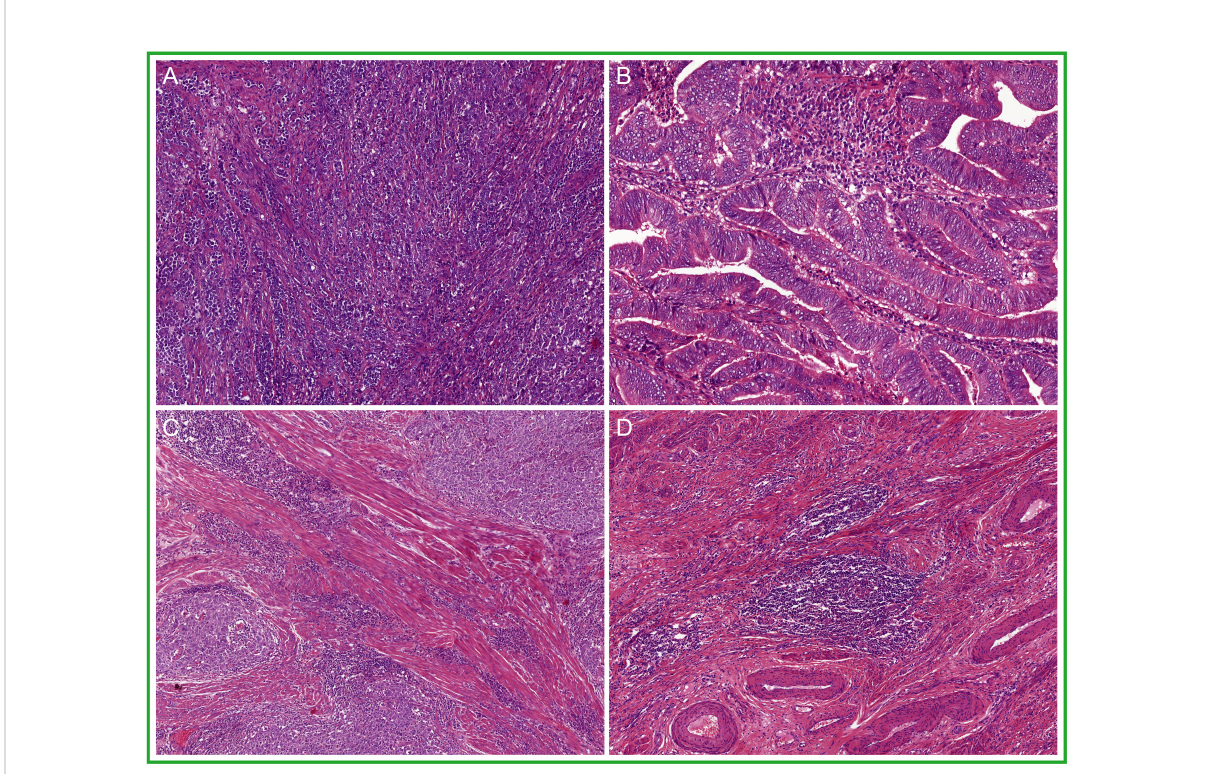
FIGURE 4 A selection of prototypical morphological features found in mismatch repair de fi cient endometrial cancer (MMRd EC): (A) solid growth; (B) glandular architecture; (C) a dense to moderate peri-tumoral and intra-epithelial in fi ltrate of lymphocytes; and (D) tertiary lymphoid structures